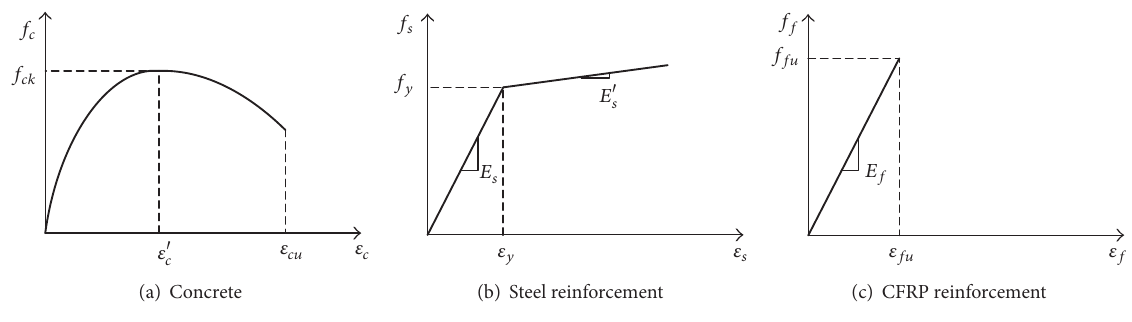
Figure 5: Material